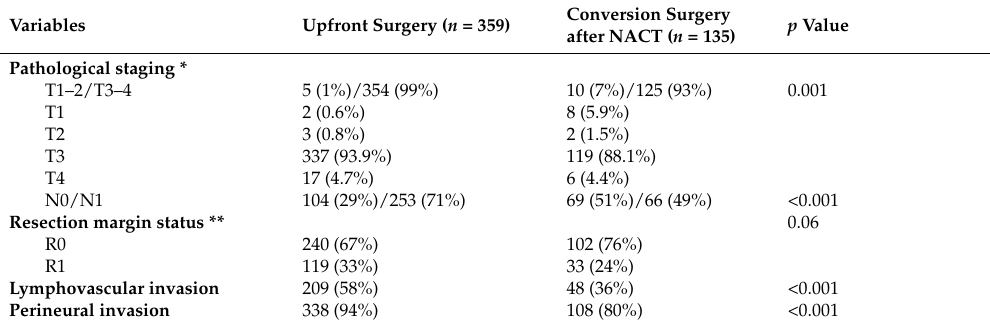
Table 2. Pathological